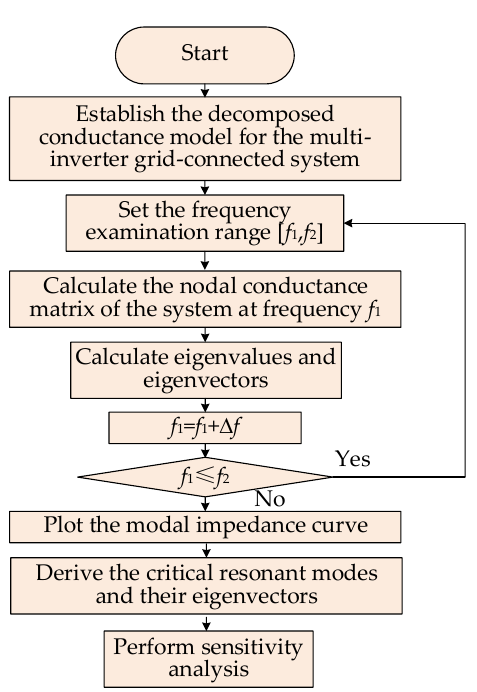
Figure 8. The specific process of resonant mode analysis. Table 1. The parameters of the grid-connected inverter.